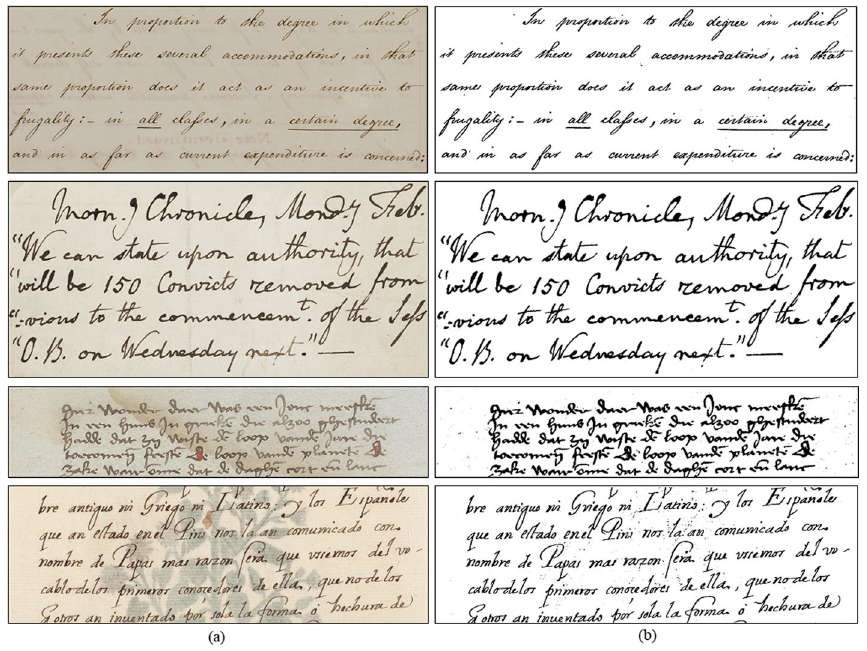
Fig. 6 Images binarization results from DIBCO 2014: a Original degraded images, b recovered text by the proposed non-local model